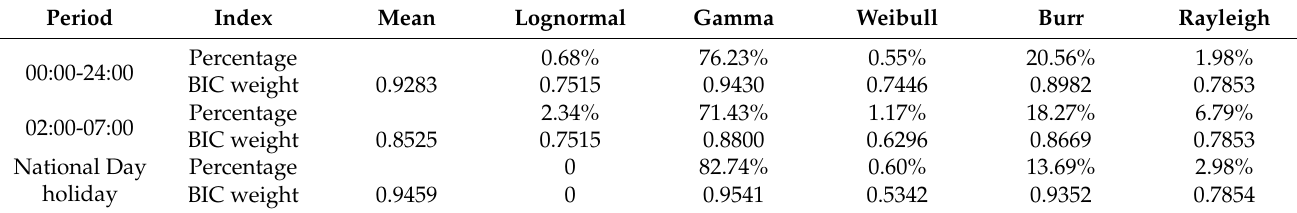
Figure 7. The fitting distributions of hourly travel time. Table 4. Statistics of best-fit distributions for travel time.